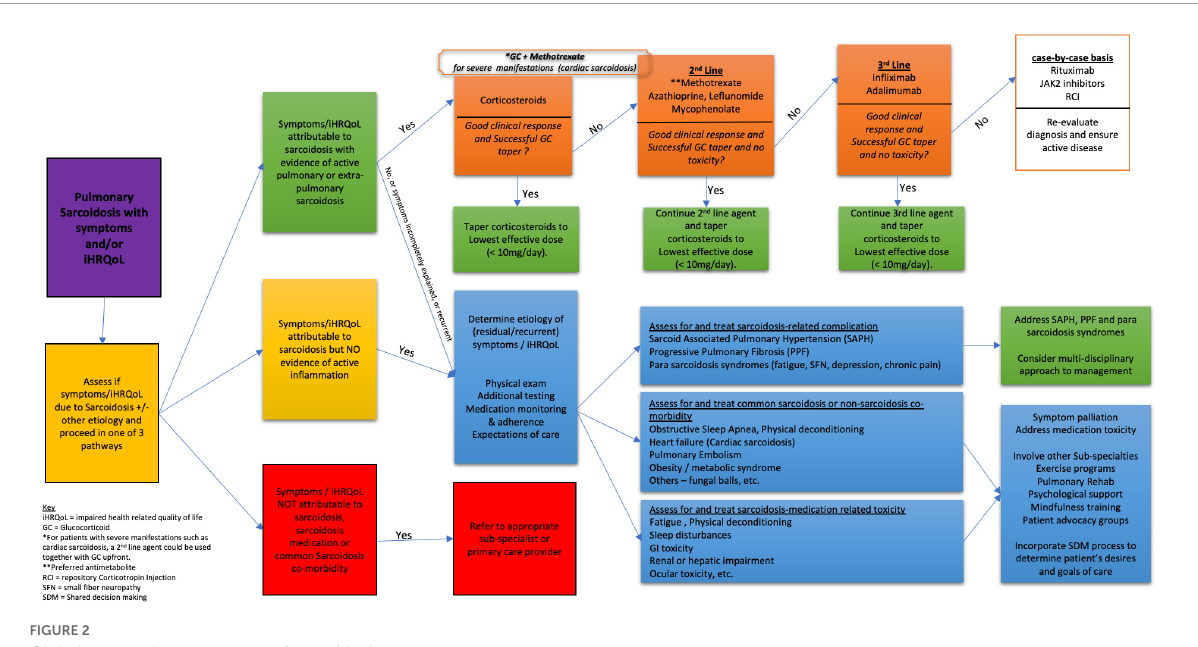
FIGURE2 Global approach to treatment of